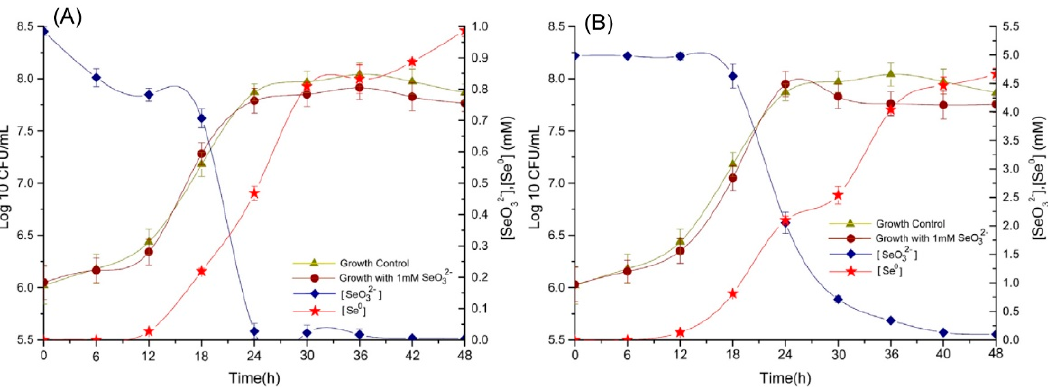
Figure 3. Bacterial growth curve, SeO 32 − reduction, and Se 0 production by the strain P. mirabilis YC801 cultured in YEP medium containing ( A ) 1 mM; and ( B ) 5.0 mM of Na 2 SeO 3 . Each test was performed in triplicate and data were presented with standard